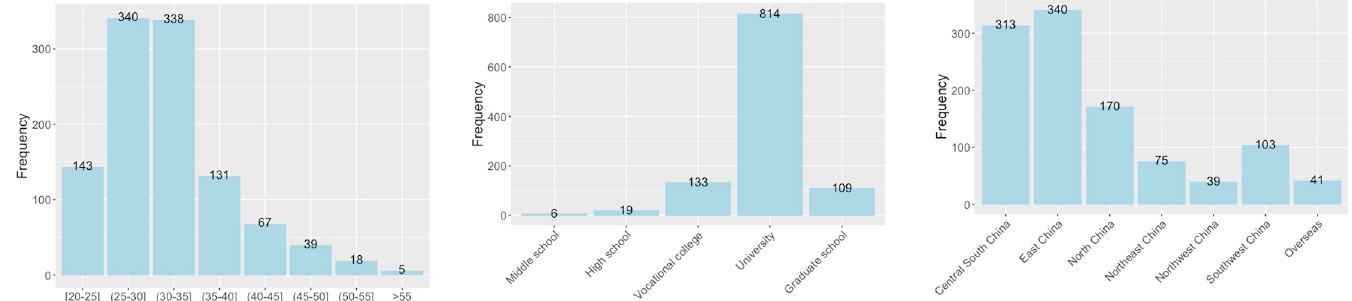
Fig 4. a. Age distribution of the participants. b. Education level distribution of the participants. c. Geographical distribution of the participants.